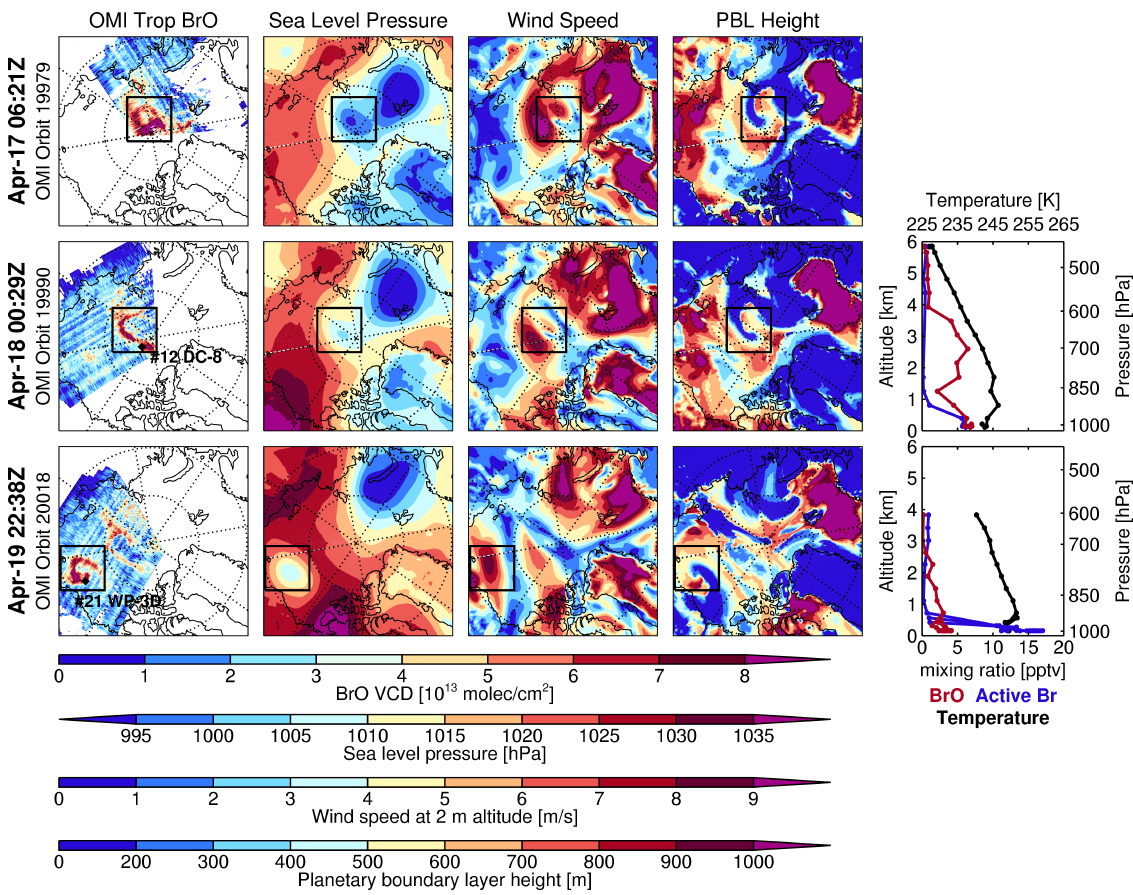
Fig. 13. First column: OMI tropospheric BrO VCD; Second column: MERRA sea level pressure; third column: MERRA wind speed at 2m altitude; fourth column: MERRA planetary boundary layer height; fifth column: aircraft in-situ profiles of BrO (red), active bromine (blue) and temperature (black). The rows correspond to OMI orbits. We show results for orbit 19979 on 17 April 2008 (top row), orbit 19990 on 18 April 2008 (middle row), and orbit 20018 on 19 April 2008 (bottom row). Aircraft profiles were not obtained during the time that the satellite data shown in the top row were acquired. An animated GIF of this figure is available in Supplemental Material.